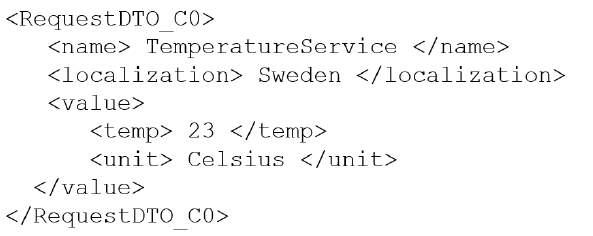
Figure 6. Example of the payload expected by the